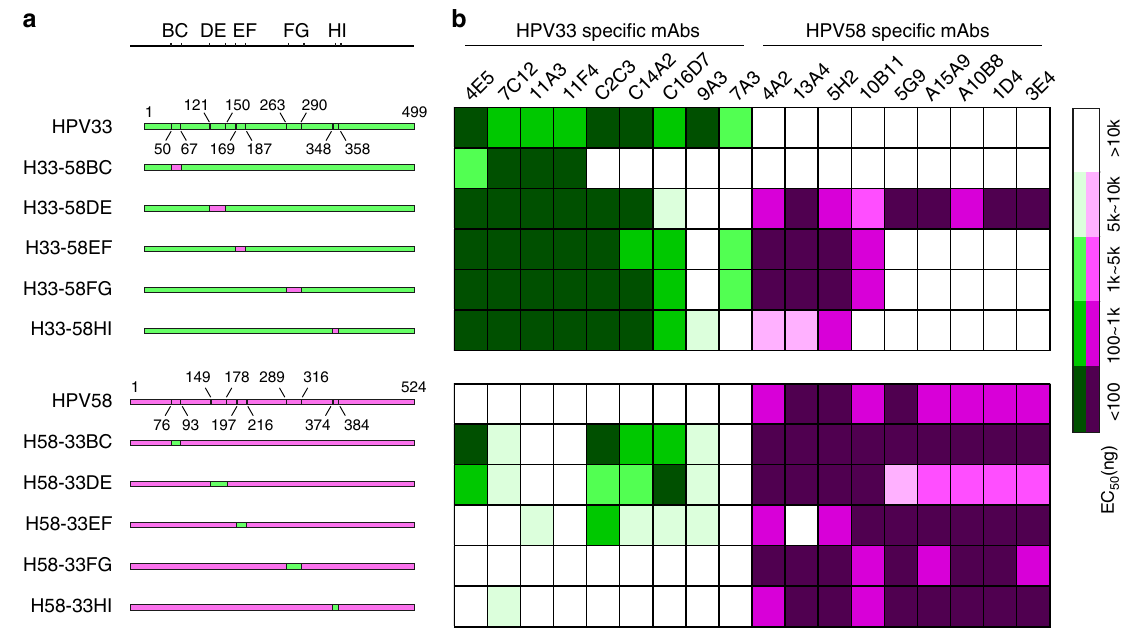
Fig. 2 Molecular design and antigenic characterization of loop-swapped HPV33/58 chimeric VLPs. a Schematic representation of the wild types (WTs) and the chimeric HPV33/58 L1 proteins. The location of surface loops for each WT or mutated L1 protein are labeled by amino acid position. b Heatmap representations of the EC 50 values of chimeric HPV33/58 VLPs based on ELISA assays against a type-speci fi c mAb panel of HPV33 and HPV58 VLPs. The key indicates the heatmap gradient. A detailed characterization of each mAb is shown in Supplementary Table